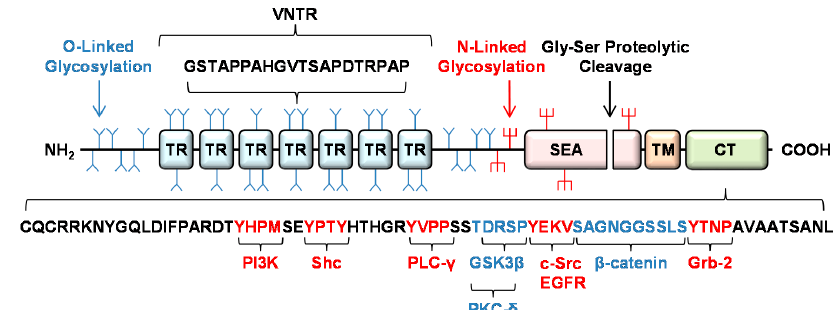
Figure 1. Schematic diagram of the MUC1 glycoprotein. Proceeding from the NH 2 -terminus to the COOH-terminus, MUC1 consists of heavily O-glycosylated ectodomain containing a variable number of tandem repeat (VNTR) region, a SEA domain with a glycine-serine (Gly-Ser) proteolytic cleavage site, a single pass transmembrane (TM) domain, and a cytoplasmic tail (CT). The amino acid sequence of a single TR is indicated. Five potential sites for N-linked glycosylation are present in the MUC1 ectodomain and SEA domain. The sequence of the 72-amino acid MUC1-CT is illustrated with potential binding sites for various kinases and adapter proteins at tyrosine-containing (red) and serine/threonine-containing (blue) sequence